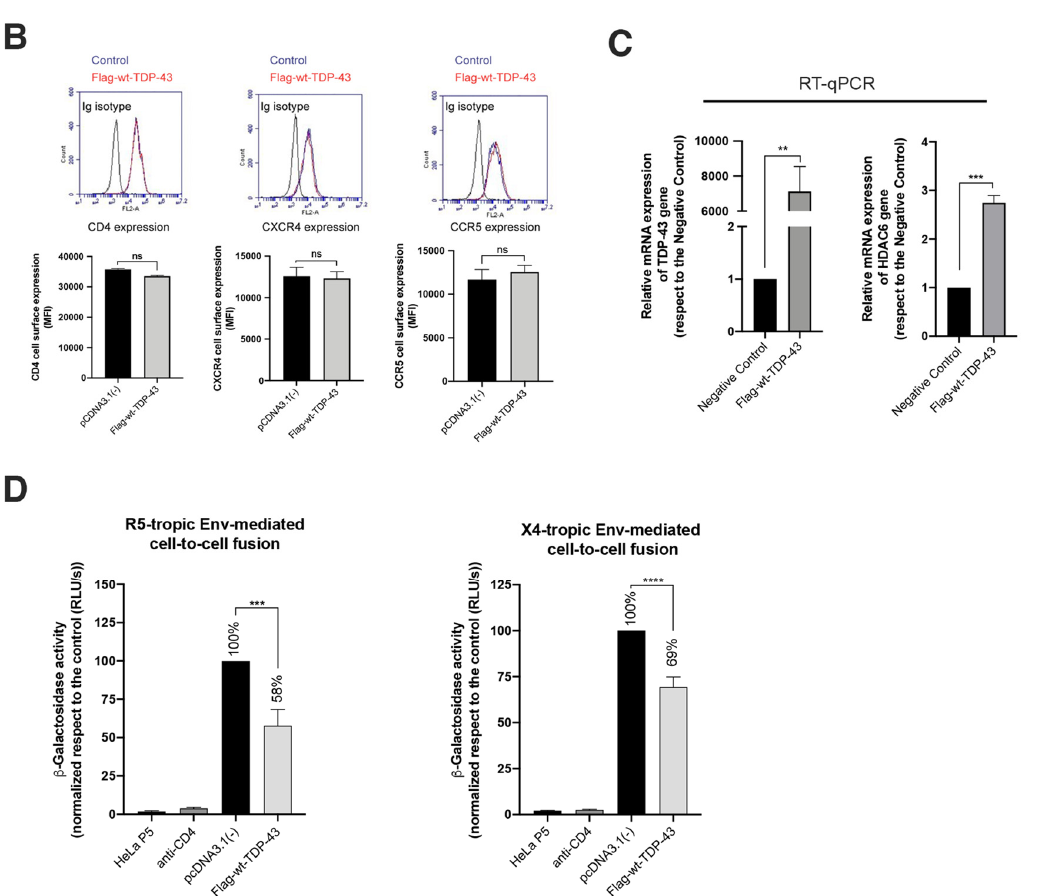
Figure 3. HIV-1 Env fusogenic activity is impaired in cells overexpressing TDP-43. ( A ) Left, total cell lysate, quantitative Western-blot analysis of HDAC6, TDP-43 and acetylated α -tubulin proteins in HeLa P5 cells overexpressing the Flag-wt-TDP-43 construct (1 µ g of cDNA) compared to control cells (pcDNA3.1( − ) transfected with the pcDNA3.1 plasmid (1 µ g)). A representative experiment of three is shown (see associated data in Figure S2 and Supplementary Materials associated infor- mation). Below, histograms quantify the amounts of HDAC6 and acetylated α − tubulin proteins, normalized by total α -tubulin, in HeLa P5 total cell lysates. Data are expressed as mean ± S.E.M. of three independent experiments. When indicated, * p < 0.05 and ** p < 0.01 are p values for Student’s t -test. Right, cell fractioning, quantitative Western-blot analysis of cell fractioning of permissive HeLa P5 cells overexpressing Flag-wt-TDP-43 (1 µ g cDNA) and its effect on endogenous HDAC6 and α -tubulin acetylation. Lamin B1 is the protein control for the nuclear fraction, whereas α -tubulin is the control for the cytoplasm fraction and total protein load. The decrease in acetylated α -tubulin levels is a read-out for the increase of the tubulin-deacetylase HDAC6 enzyme. A representative experiment of three is shown (see associated data in Figure S2 and Supplementary Materials asso- ciated information). Below, histograms quantify the intensities of Western-blot bands from HeLa P5 cell fractioning, representing the amounts of cytoplasmic HDAC6 and acetylated α -tubulin (both from cytoplasmic tracks 1 and 2) in control and Flag-wt-TDP-43 expressing cells, and normalized by total α -tubulin control load (Western-blot tracks 1 and 2). Tracks 3 and 4 are nuclear fractions for control and Flag-wt-TDP-43 expressing cells, respectively. Φ indicates empty track. Data are mean ± standard error of the mean (S.E.M.) of three independent experiments (see associated data in Figure S2 and Sup- plementary Materials associated information). When indicated, ** p < 0.05 is the p value for Student’s t -test. ( B ) Flow cytometry analysis of CD4, CXCR4 and CCR5 cell-surface expression in permissive HeLa P5 cells overexpressing the Flag-wt-TDP-43 construct compared to control cells (transfected with pcDNA.3.1). Data are mean ± S.E.M. of three independent experiments carried out in triplicate.